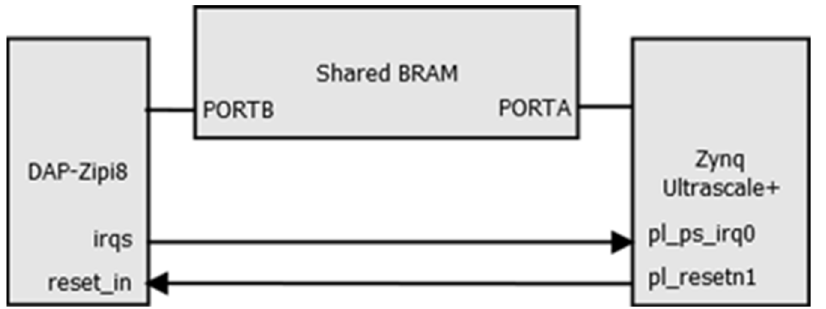
Figure 15. Hardware setup for DAP-Zipi8 verification using a math library on a Xilinx Zynq Ultra- scale+ ZCU104 development